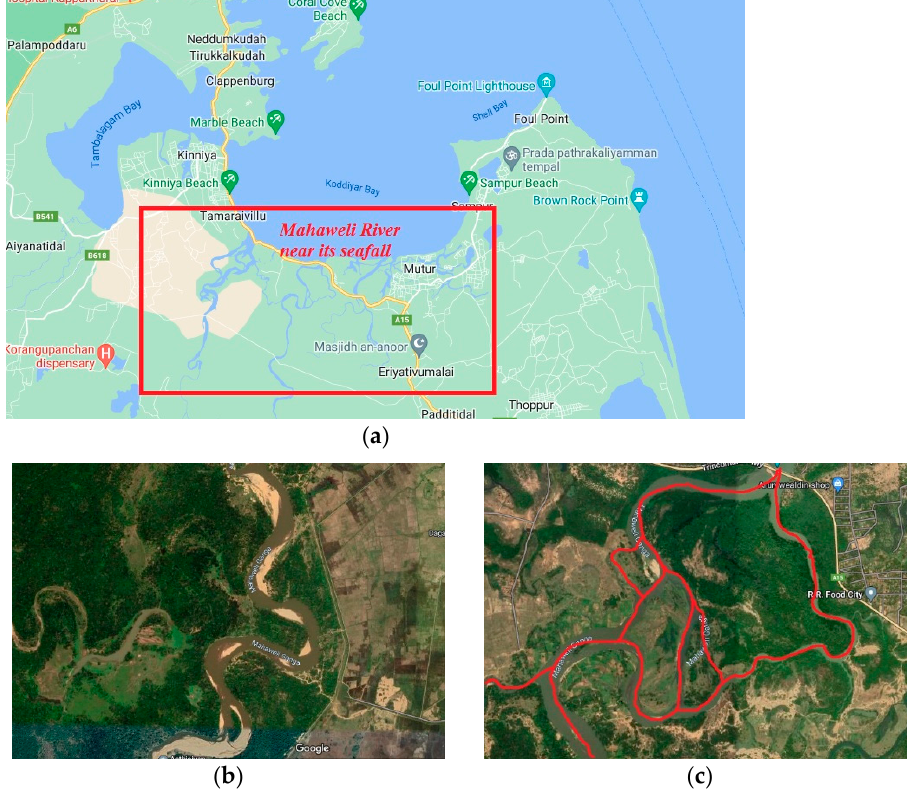
Figure 1. River meandering behavior: ( a ) Mahaweli River near its sea outfall; ( b ) sediment deposition along the river; ( c ) complex river path with river planforms (source: Google maps).